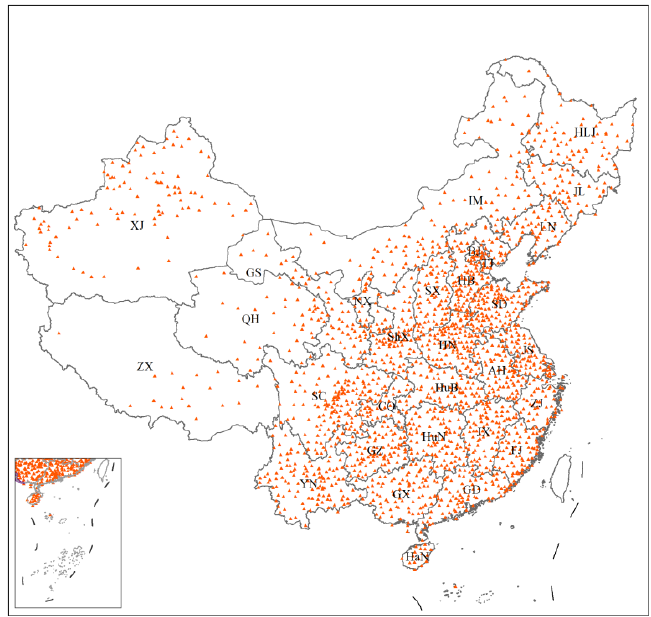
Figure 1. The location of the study region (Triangular points represent the location of meteorological observation stations).